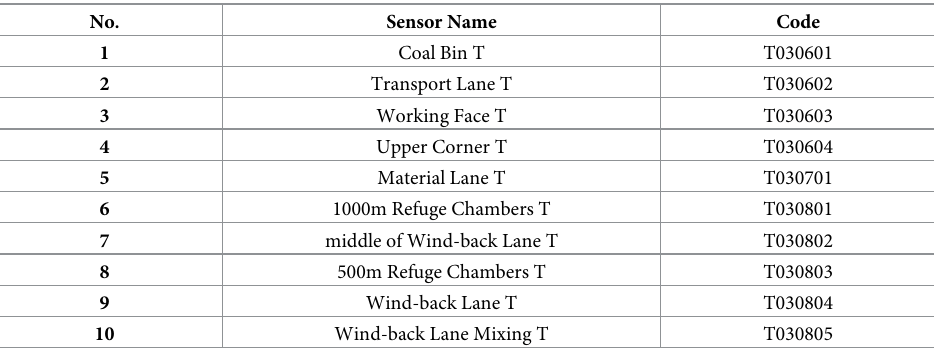
Table 2. Code of sensors in Case Study mine 1.